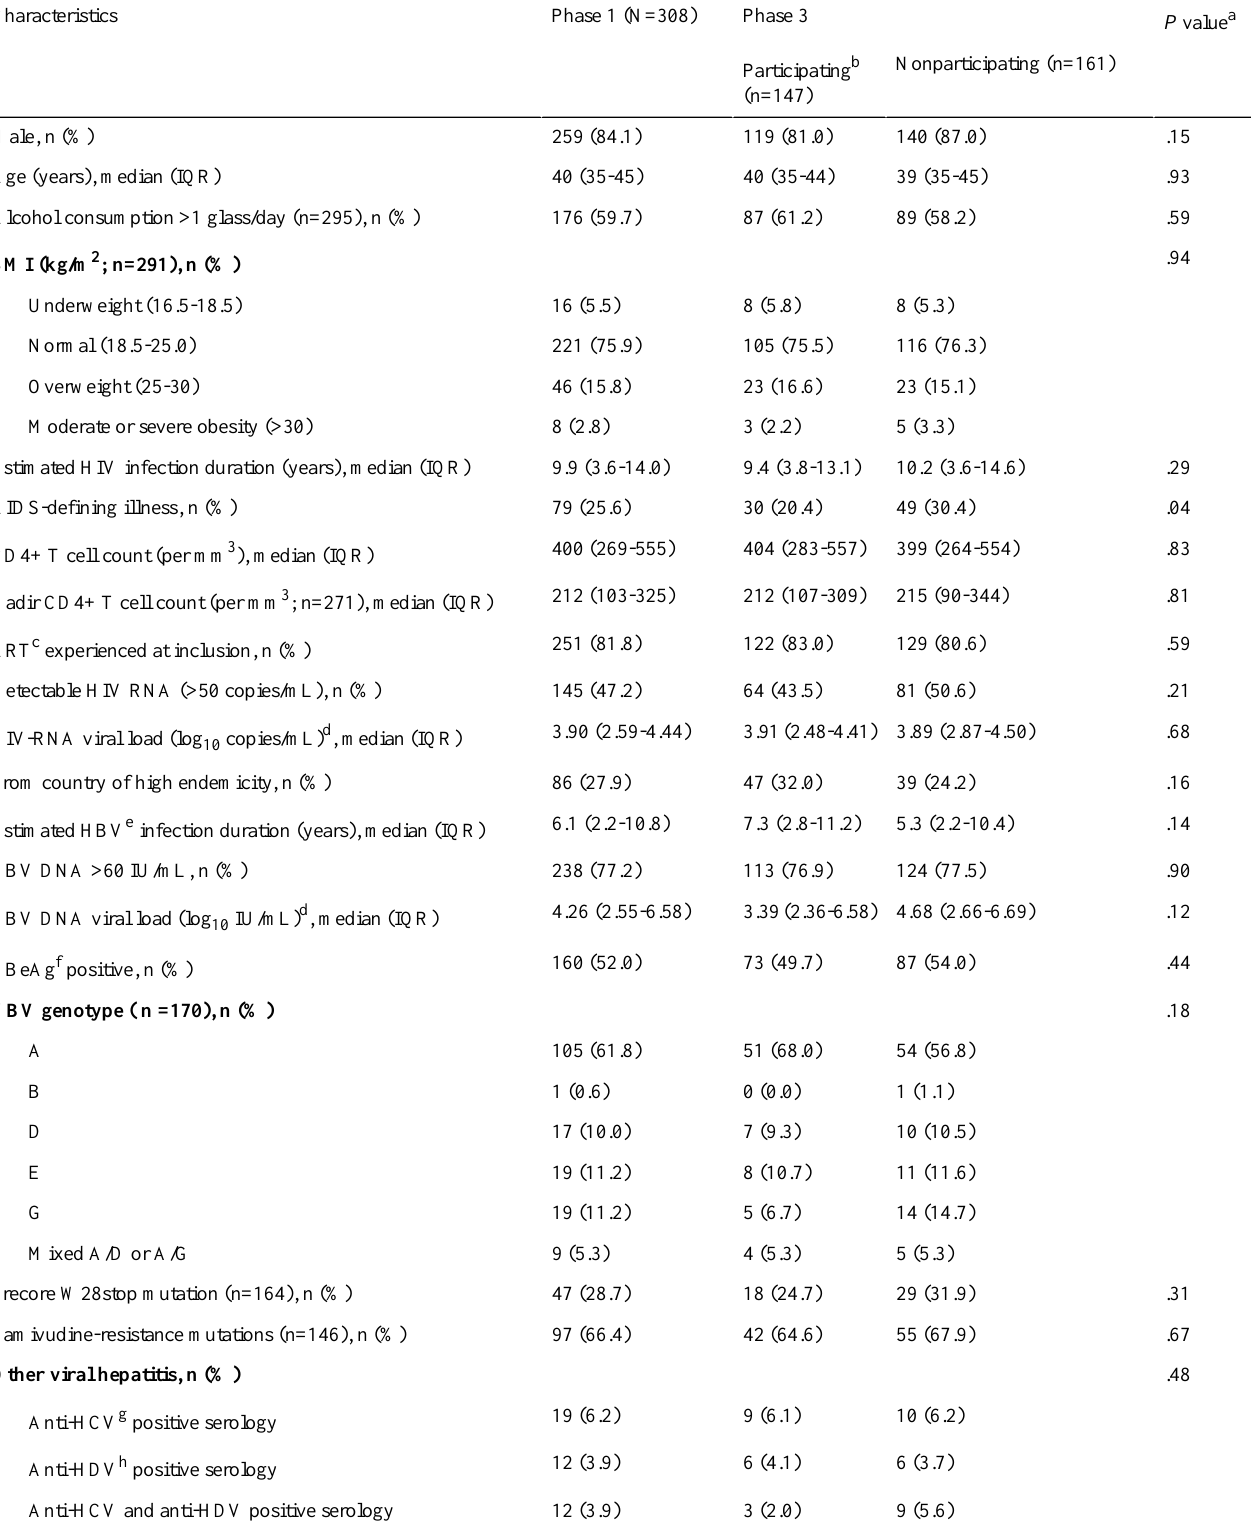
Table 2. Characteristic of the study population at cohort inclusion, stratified by participation in the third phase cross-sectional study